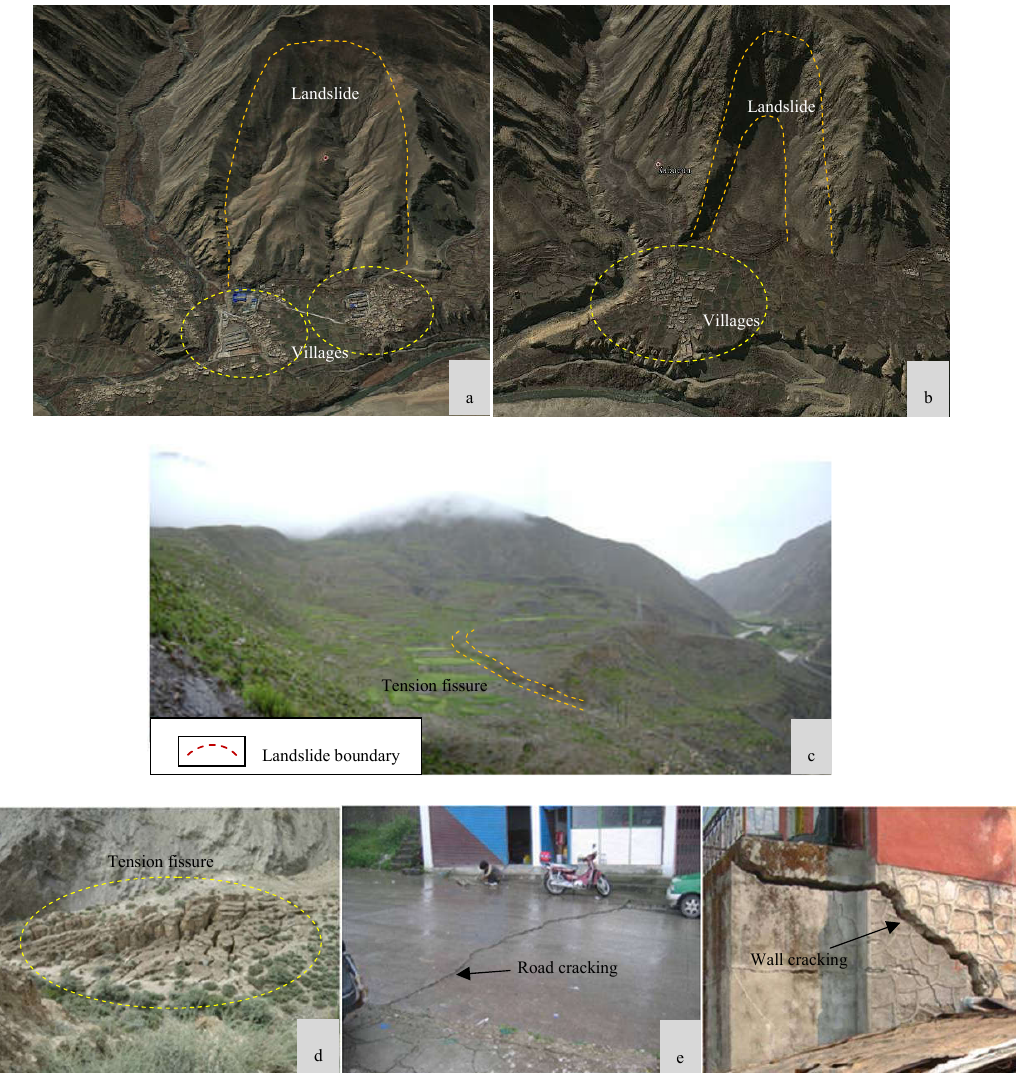
Figure 4. Typical landslides and their impacts on residents within the study area. ( a ) Lunba Landslide in a tributary. ( b ) Zhuolonglang landslide in Jiayu County. ( c ) Mentang power station landslide. ( d ) Landslide due to a tension fissure in Danglaimu. ( e ) Sino-Nepalese Highway cracking. ( f ) Wall cracking in a Public Security Bureau computer room.